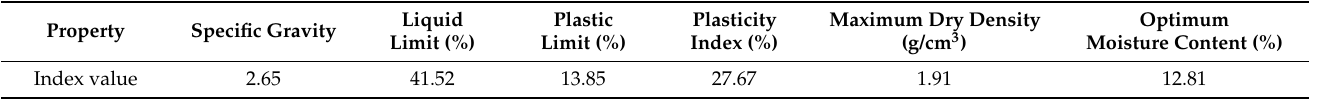
Table 1. Index properties of clay soil.